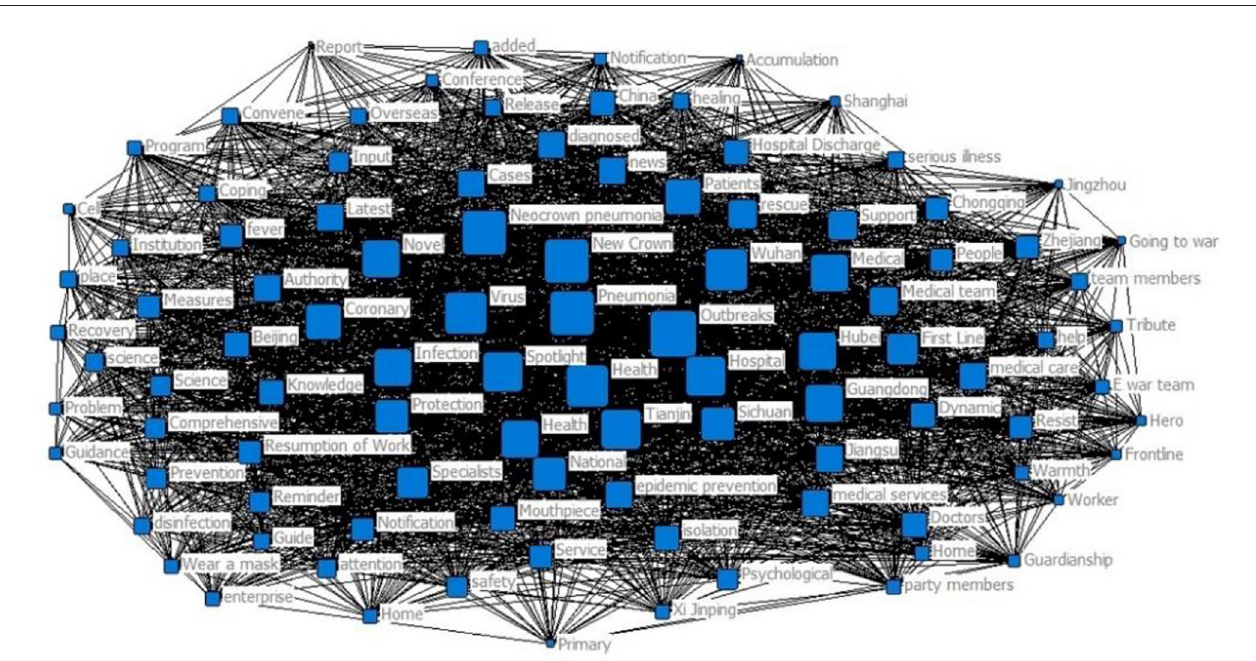
FIGURE 8 | Tweets high-frequency words co-occurring network